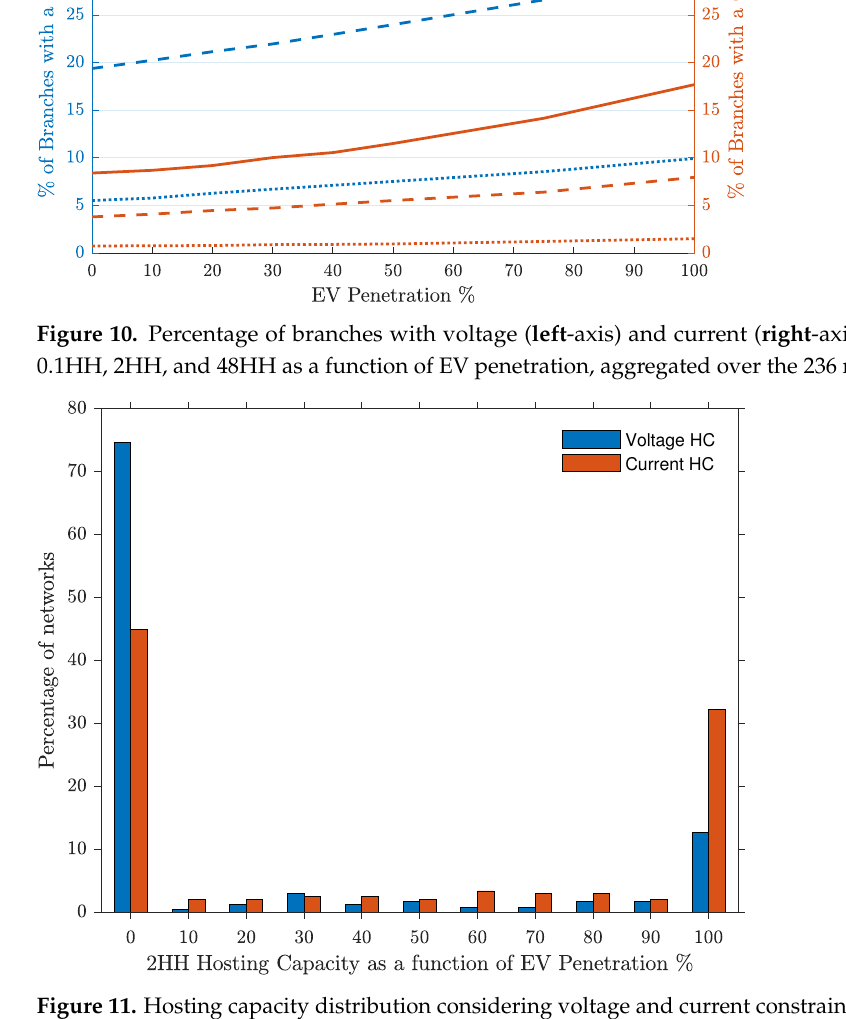
Figure 11. Hosting capacity distribution considering voltage and current constraints as a function of EV penetration for the 236 networks and using the 2HH as a